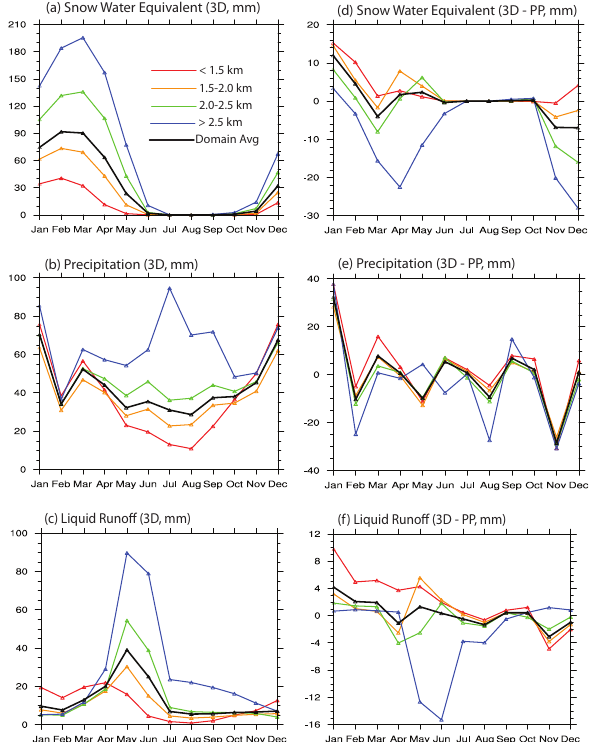
mm), (b) precipitation (mm), and (c) runoff and the corresponding deviations (3-D–PP) in (d) SWE, (e) precipitation, and (f) runoff, averaged over the simulation domain for a 12-month period as a function of elevation lower than 1.5km (red), 1.5–2km (orange), 2–2.5km (green), above 2.5km (blue), and for the whole domain